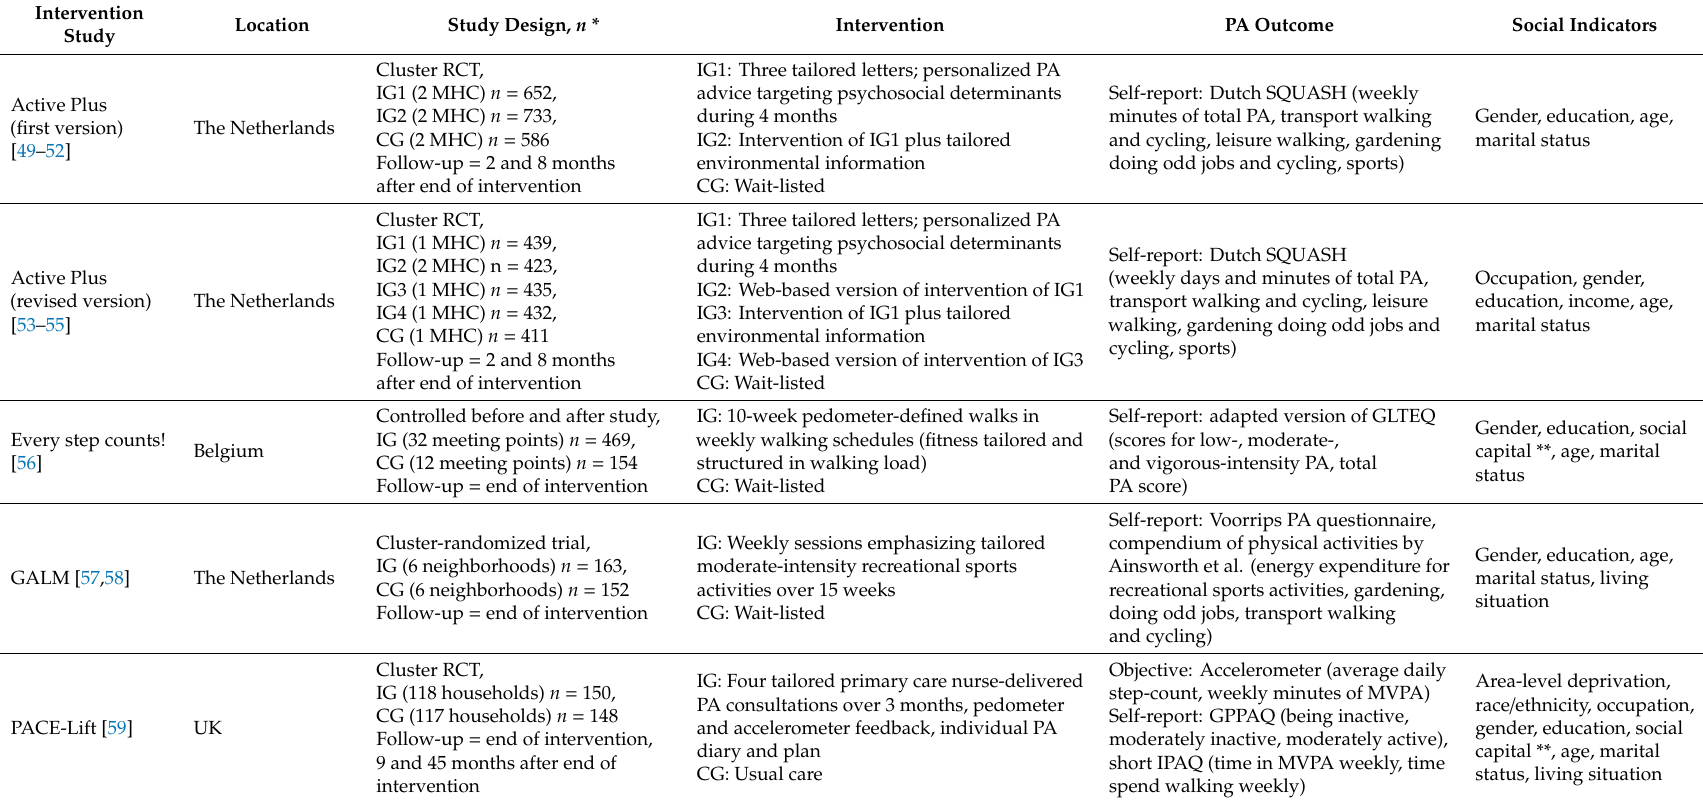
Table 1. Characteristics of intervention studies taking part in the